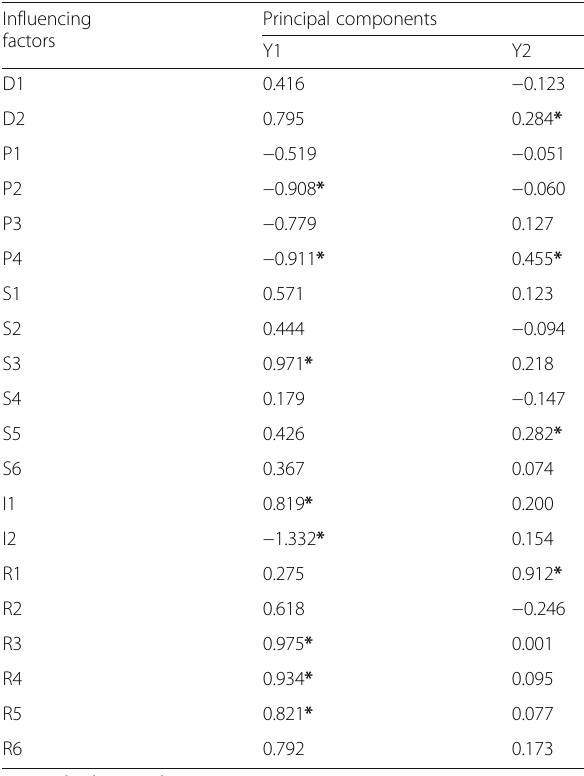
Table 5 Principal component load matrix of green mine construction Influencing factors